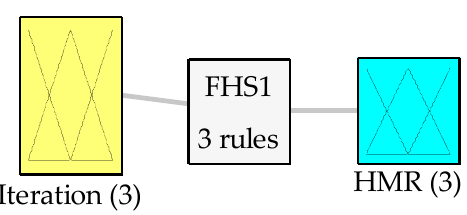
Figure 5. Fuzzy System for Increasing HMR .